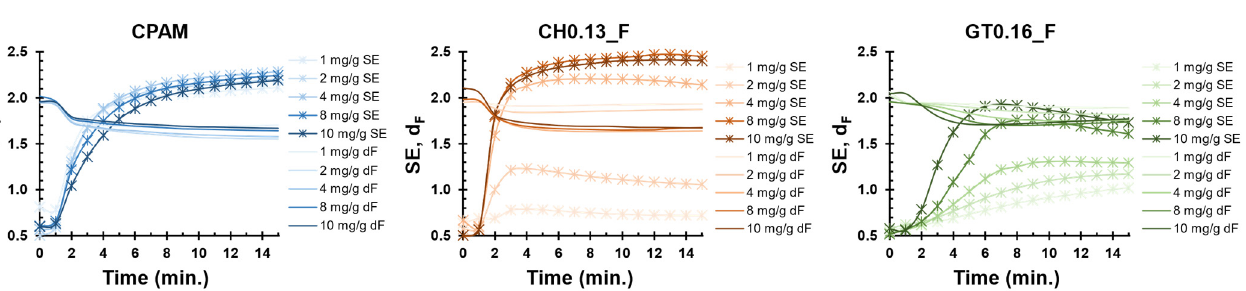
Figure 7. Evolution of the scattering exponent (SE) and mass fractal dimension (d F ) as a function of flocculation time for several concentrations of the best flocculants.